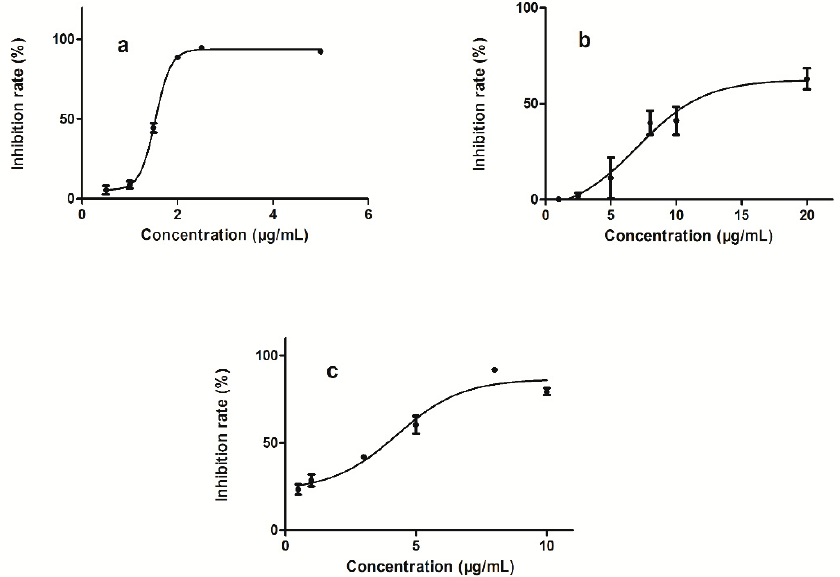
Figure 5. Cell viability inhibitory e ff ects in HL-7702 cells treated with sanguinarine ( a ), coptisine ( b ), chelerythrine ( c ).